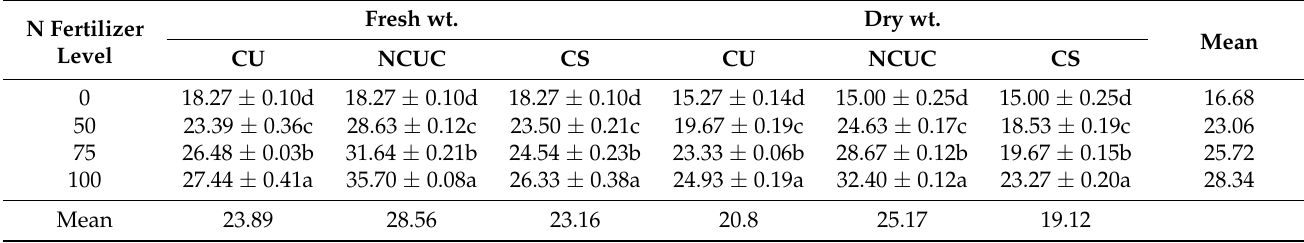
Table 3. Effect of different sources and concentrations of fertilizers on shoot fresh and dry weight (g) parameters. Fresh wt. Dry N Fertilizer Level